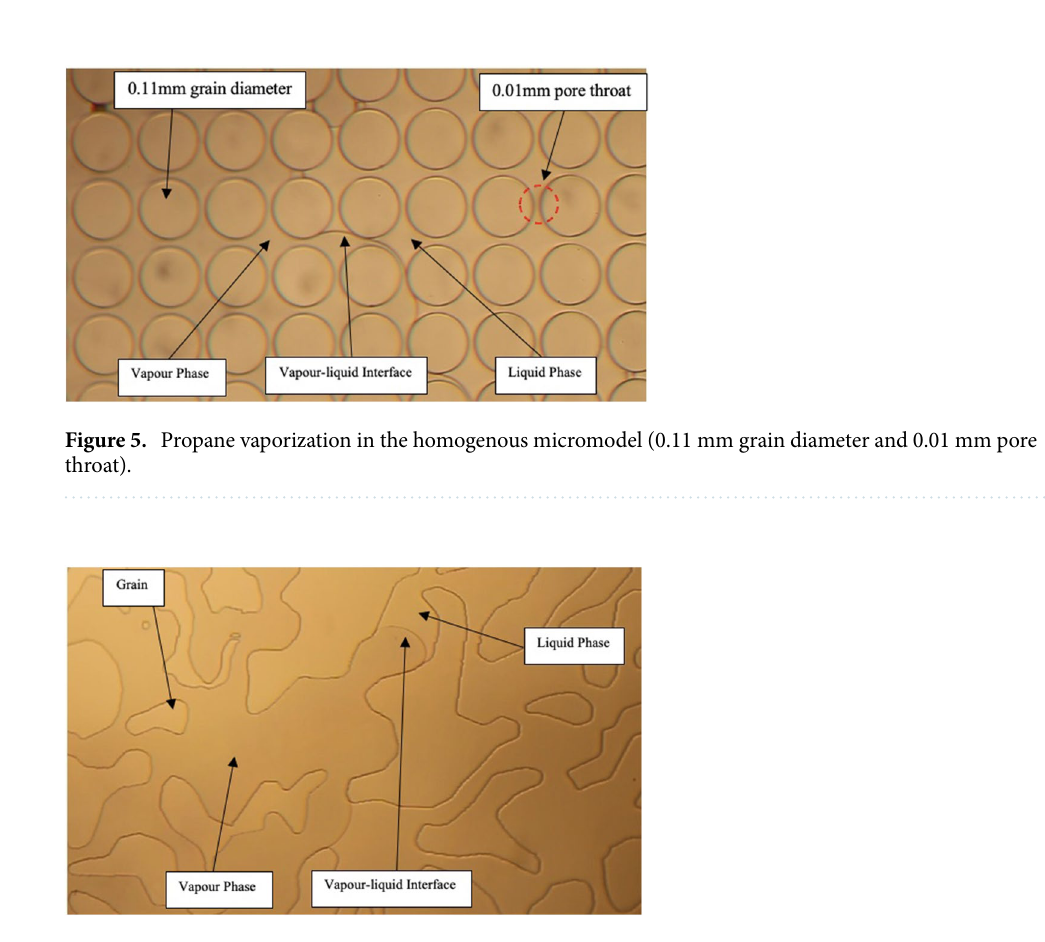
Figure 6. Propane vaporization in the heterogeneous micromodel (average pore throat size of 142.5 μm).